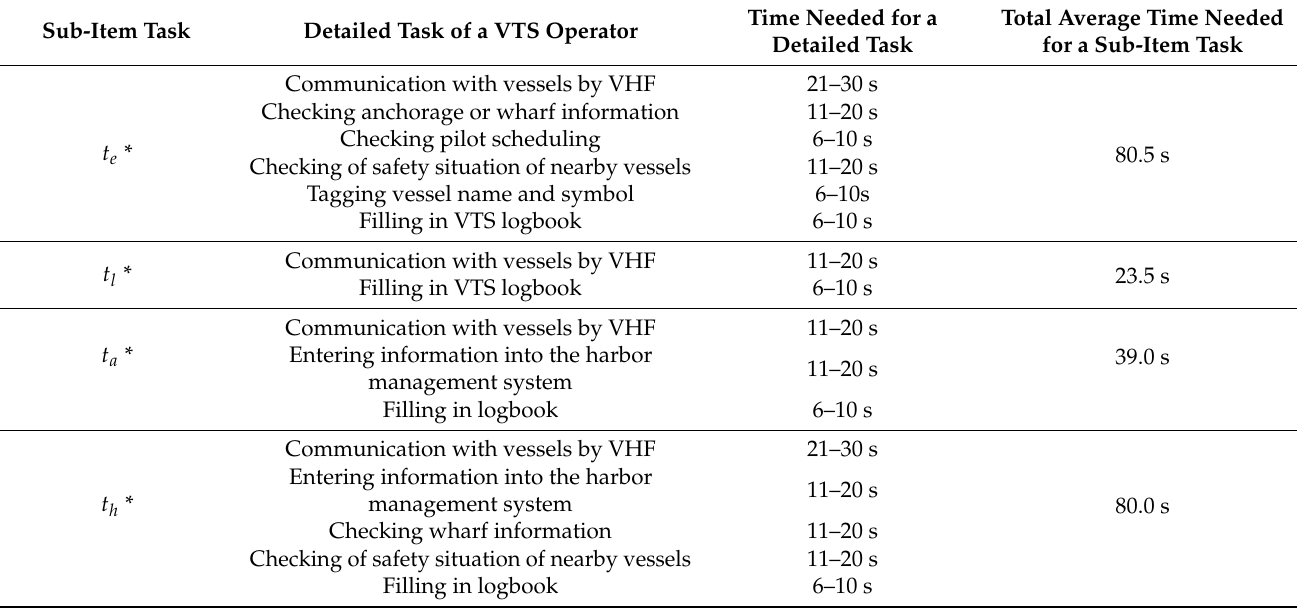
Table 3. Detailed task of a VTS operator and total time needed for sub-item tasks of NAS. Sub-Item